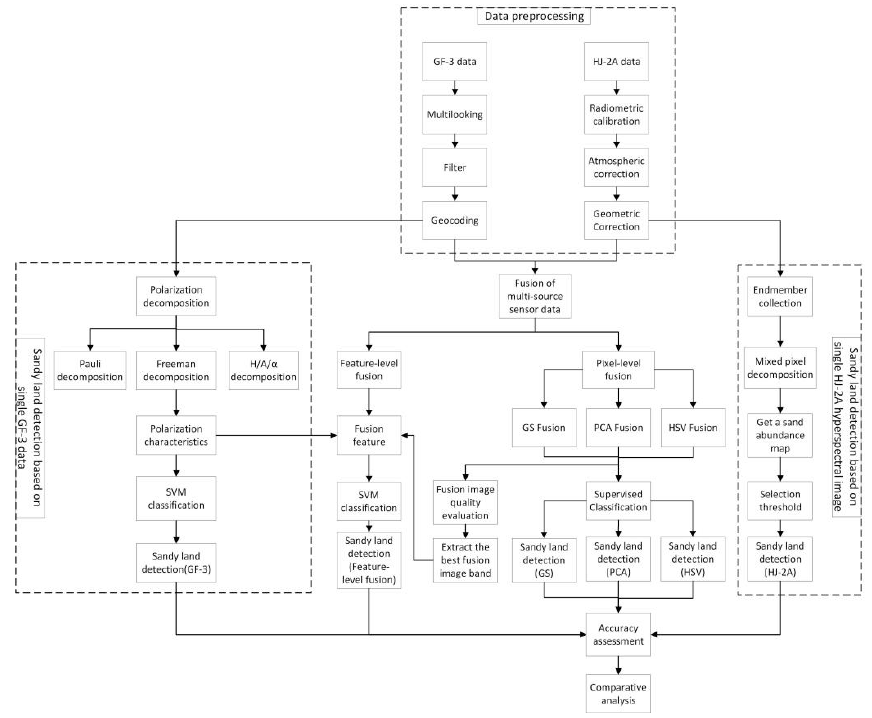
Figure 3. Technical flow